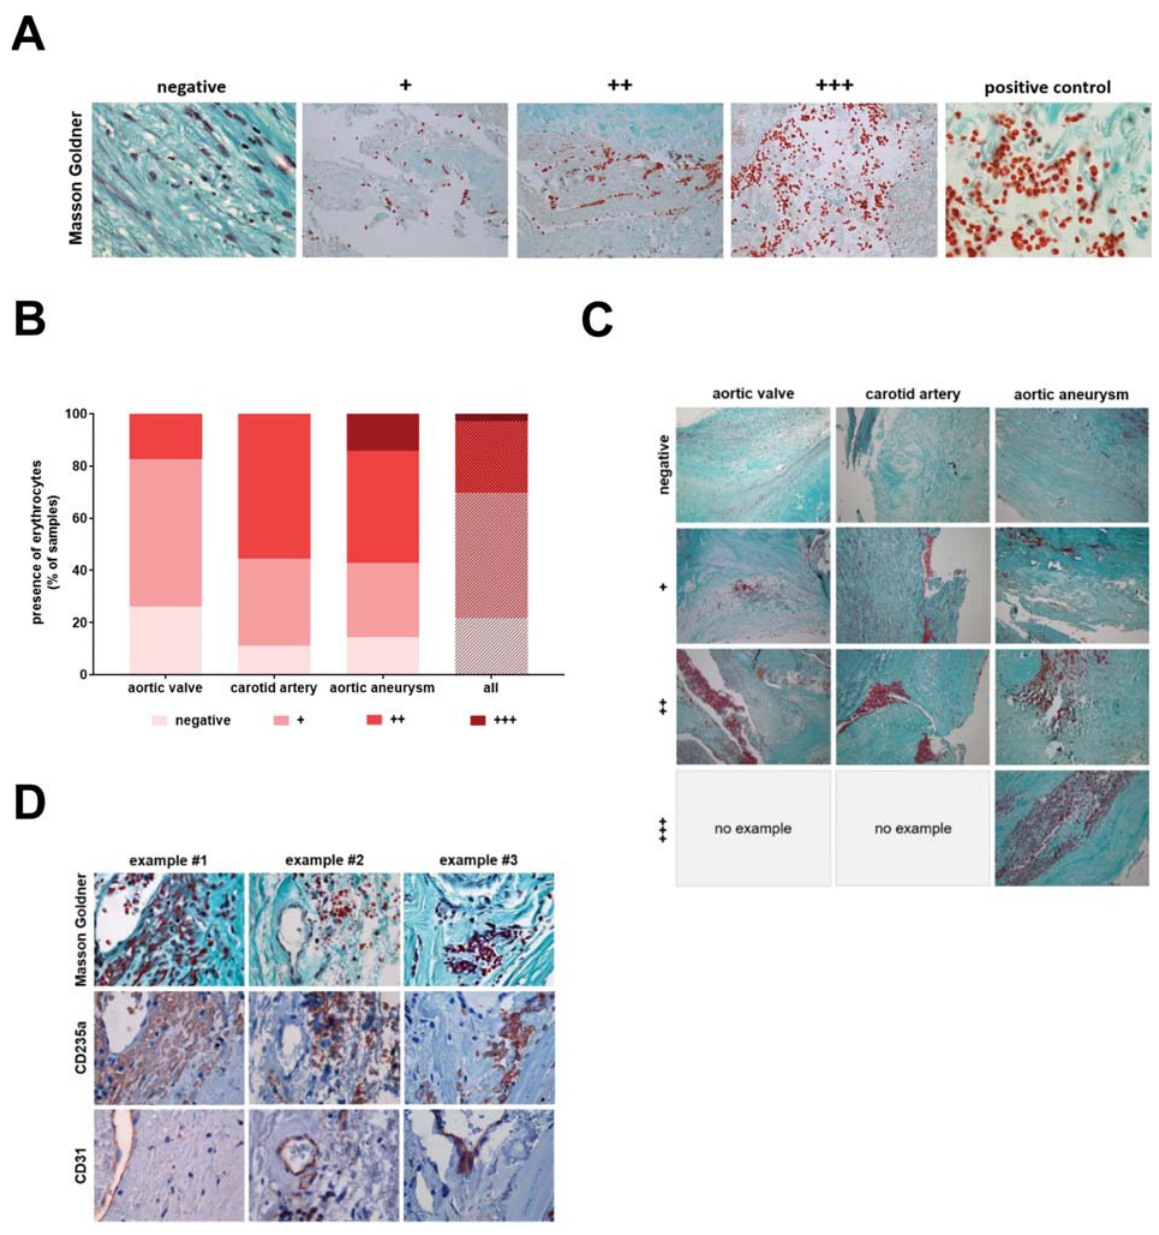
Fig.1 Detectionoferythrocytesinhumanvascularlesions.( A )Examplesoftheextentoferythrocyteextravasationanditsgradinginabsent(negative),low (+), middle (++) and high (+++). The positive control shows a higher magni fi cation of the typical erythrocyte shape (bright red signal), the example for a negativeresultshowssmoothmusclecells/myo fi broblastsinpink,whereasbrightrederythrocytesareabsent;1,000-fold(negativeandpositivecontrol)and 200-fold(allothers)magni fi cations.( B )Resultsofthequantitativeanalysis.Resultsareexpressedaspercentage(%)ofthetotalnumberoftissuesamples.( C ) Representative fi ndings of erythrocytes in samples of human aortic valve, carotid artery plaque and aortic aneurysm; 200-fold magni fi cation. ( D ) Three examplestodemonstratetolocalizationoferythrocytesfollowingMasson – Goldnertrichromestaining(toprow)orCD235aimmunohistochemistry(middle row) in relation to intralesional CD31-immunopositive endothelial cells lining vascular structures are shown; 1,000-fold magni fi cation.